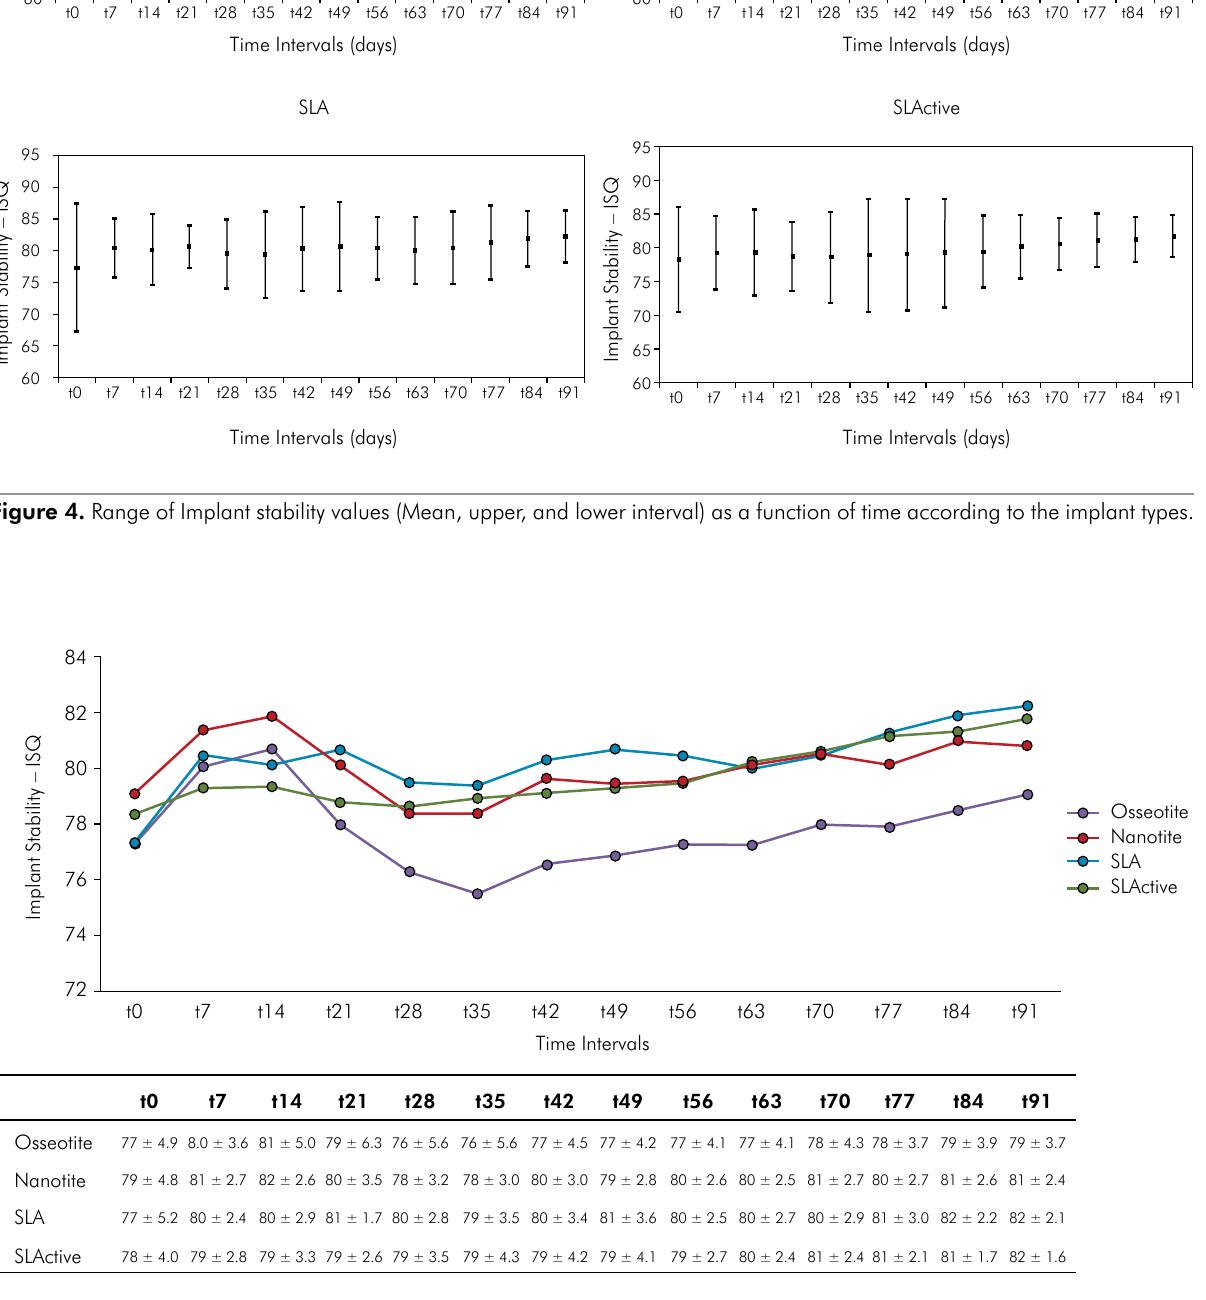
Figure 5. The ISQ of all implant surfaces as a function of time (mean ±